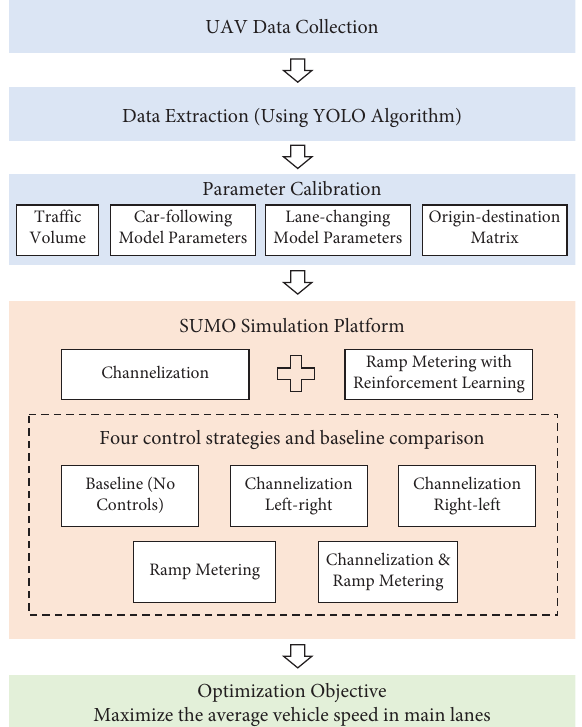
Figure 1: Te streamlined fowchart of the trafc state optimization.